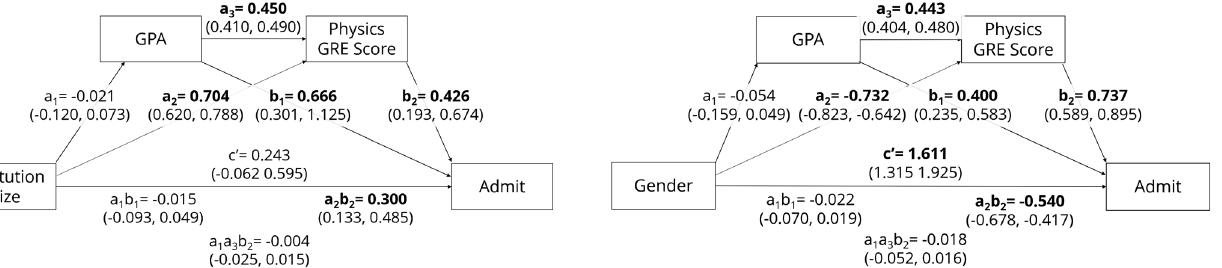
FIG. 11. Visual representation of the bootstrapped coefficients in Eqs. (5) to (7). We do find evidence of the physics GRE score mediating institution size and admission status but do not find evidence of GPA mediating institution size and admissions status. We do not find evidence of a serial mediating relationship. Statistically significant coefficients are in bold.